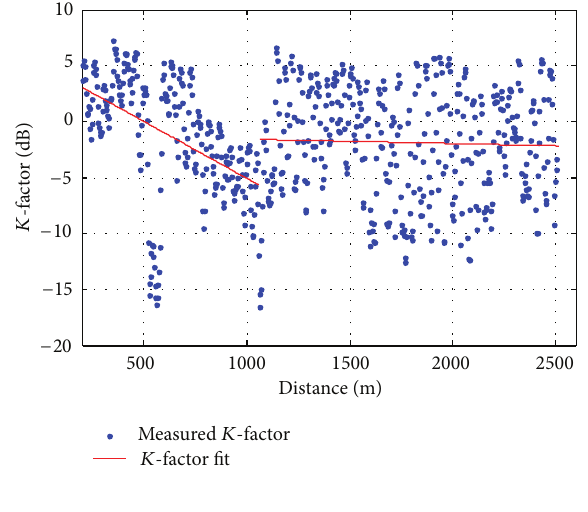
Figure 8: K -factor in hilly